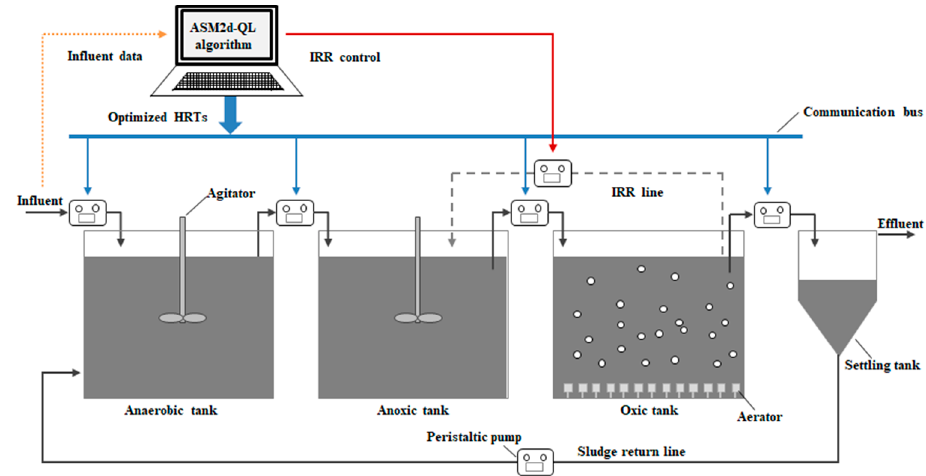
Figure 1. The schematic flow diagram of the continuous-flow anaerobic / anoxic / oxic (AAO) systems for model validation. Table 1. The characteristics of the influent concentrations in the eight AAO systems.